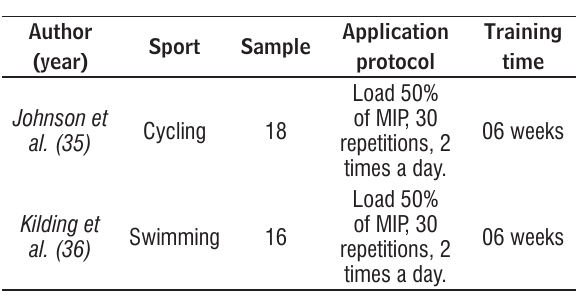
Table 1 - Stratification of IMT studies in the athlete through the PEDro Scale.PEDro (Physiotherapy Evidence Database), available from http://www.